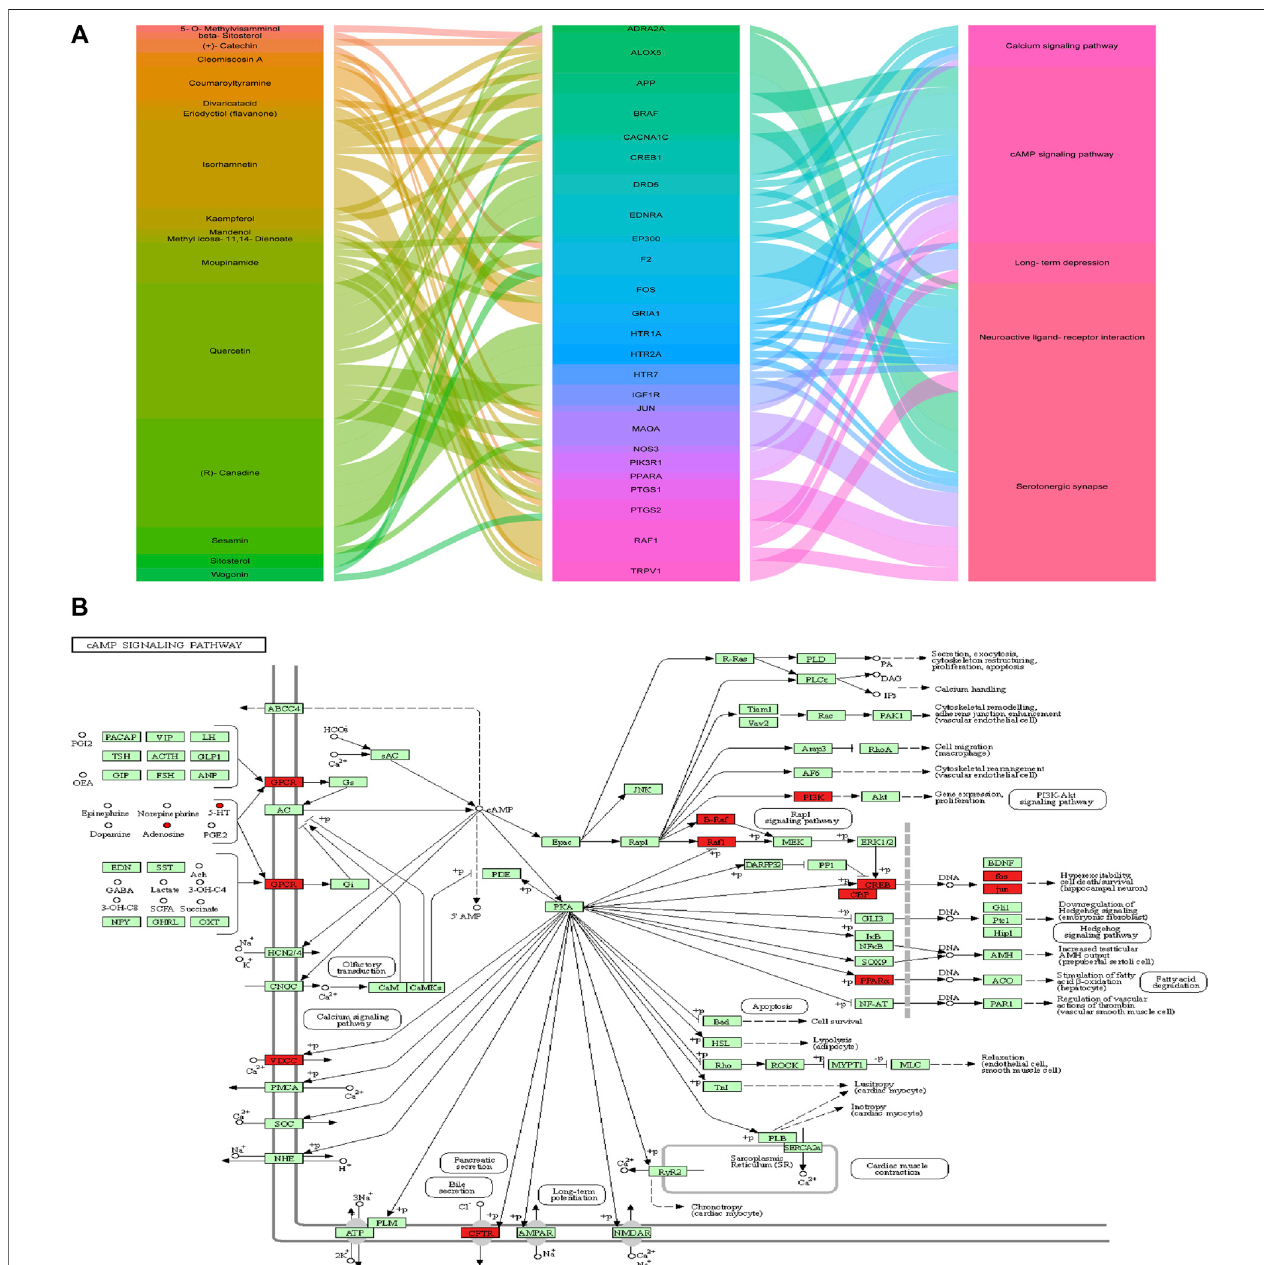
FIGURE 11 | Metabolism-protein networks. (A) Sankey diagram of the interaction between botanical drugs of CKF, major hub genes, and main pathways. Note: the botanical drugs, major hub genes, and main pathways are shown in different colors. The height of the rectangle and the width of the connecting line are positively correlatedwiththenumberoftheotherrectanglesthattheyareconnectedto. (B) Metabolism-proteinnetworksforcAMPsignalingpathway. ○ Metabolites █ Keyprotein targets.